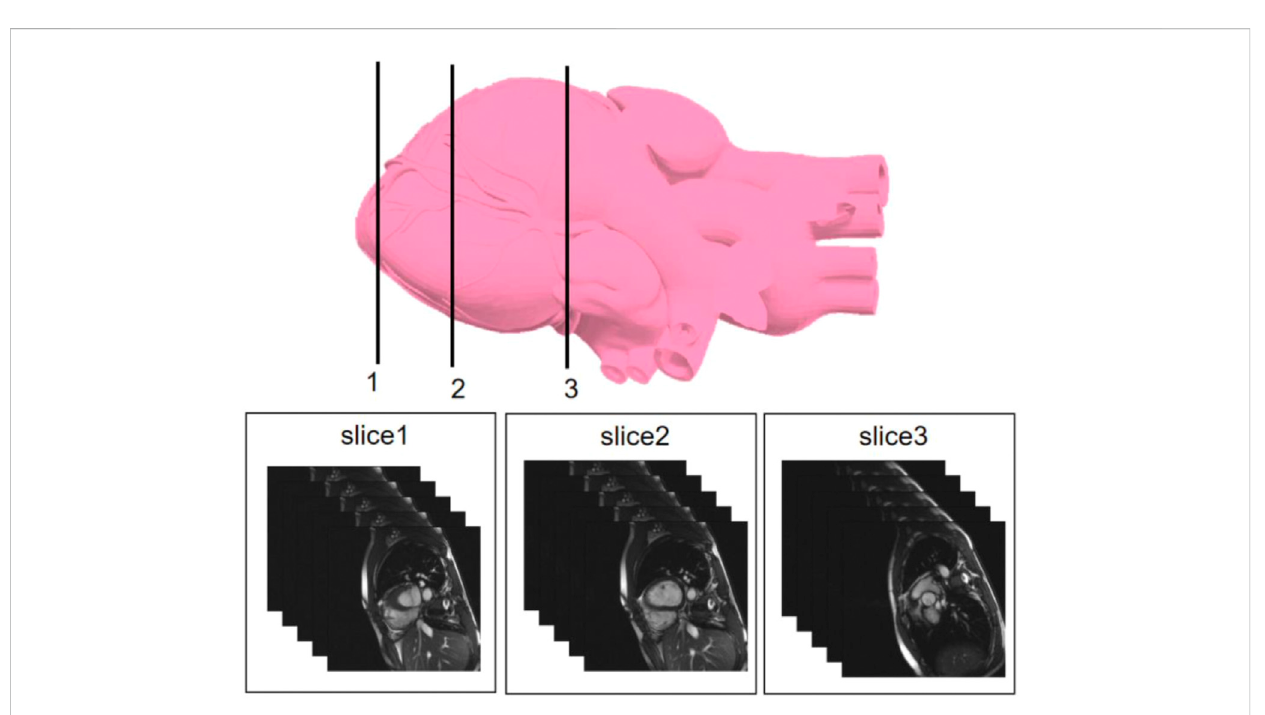
FIGURE 3 Cardiac MRI sampling locations included in this